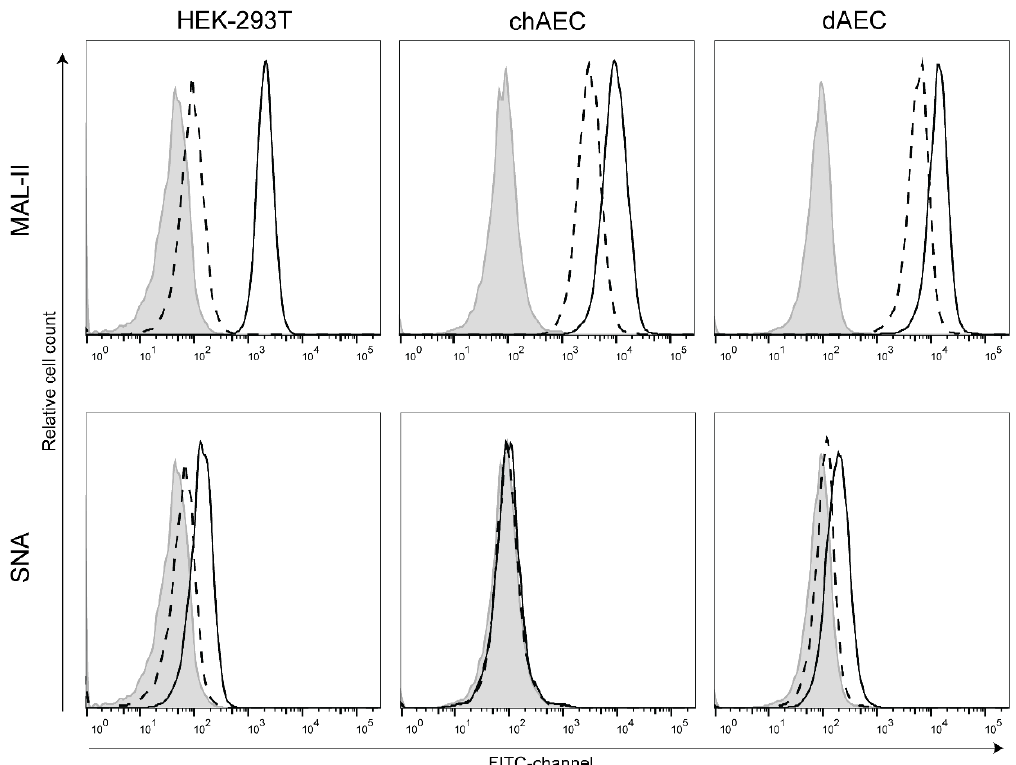
Figure 2. Sialic acid expression on the surface of primary avian endothelial cells. HEK-293T cells (p29), chAEC (p15), and dAEC (p16) were incubated for 2 h in medium with (dashed line) or without (black solid line) sialidase. Cells were stained with MAL-II ( α 2,3-specific) or SNA ( α 2,6-specific) lectins and subjected to flow cytometry. The negative control (in grey) consisted of untreated cells from which the lectins were omitted during the staining process. Representative flow cytometry histograms of at least three independent experiments are